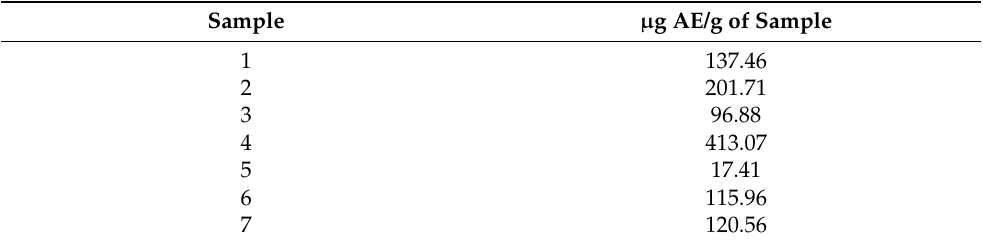
Table 8. Results expressed in µ g AE/g of sample (Folin-Ciocalteu method).